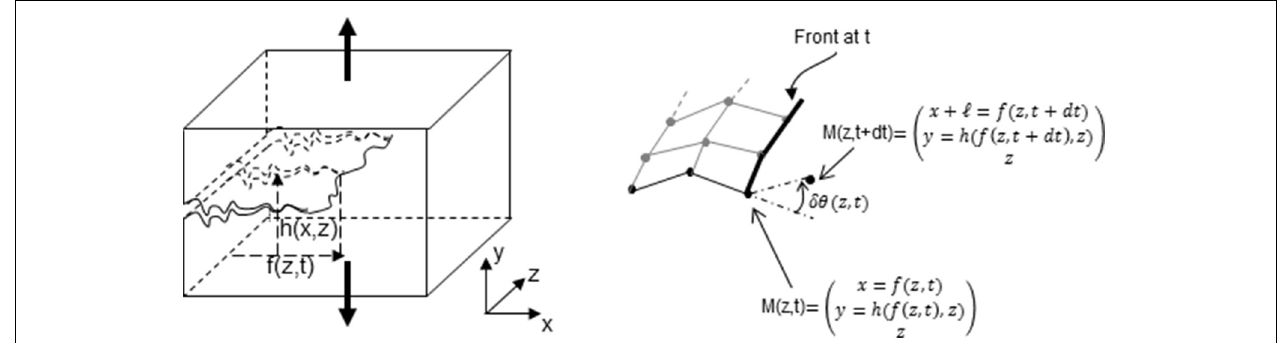
FIGURE 1 | Left: Sketch and notation of a crack front propagating in a heterogeneous solid. Right: Decomposition of the crack path into infinitesimal straight